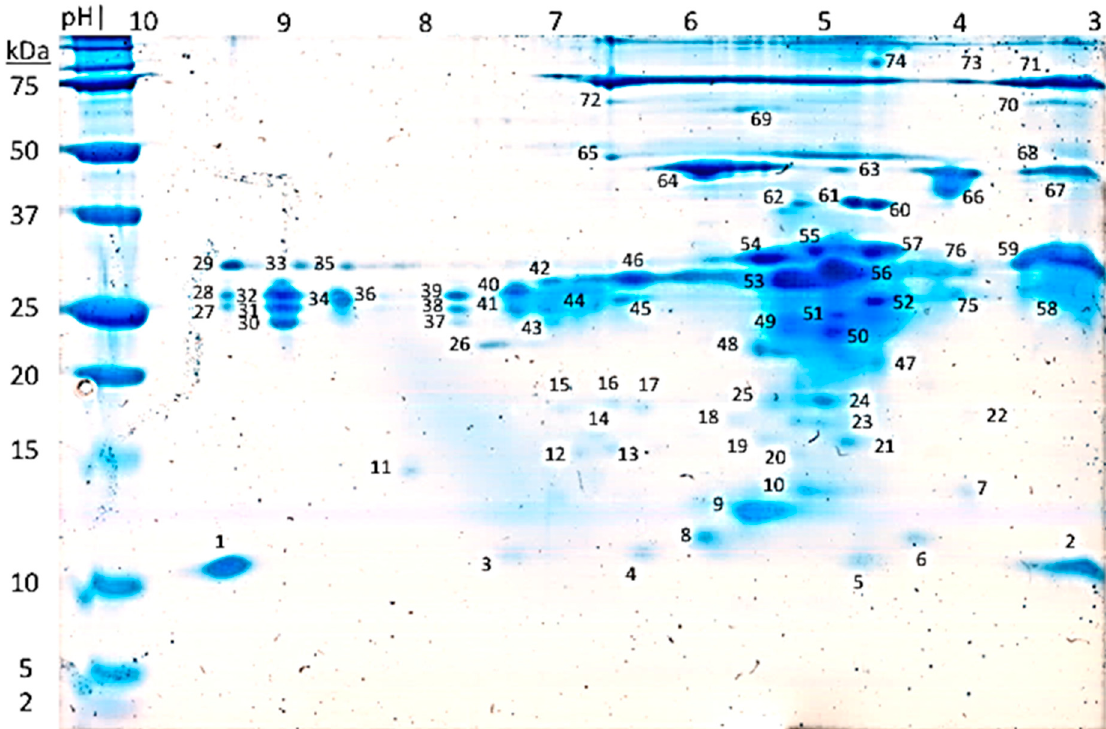
Figure 1. D. arenicolor ’s skin secretions extract (SSE) Tricine-2D polyacrylamide gel electrophoresis (2D-PAGE). 150 µg of SSE analyzed by Tricine-2D-PAGE yielded 76 spots stained with Colloidal Coomassie Blue.